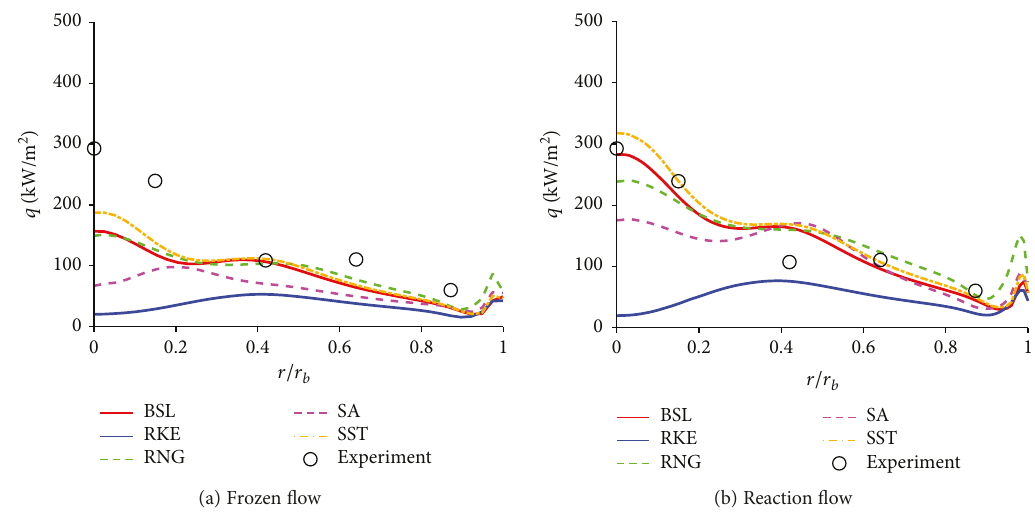
Figure 13: Radial heat fl ux distribution on the base.